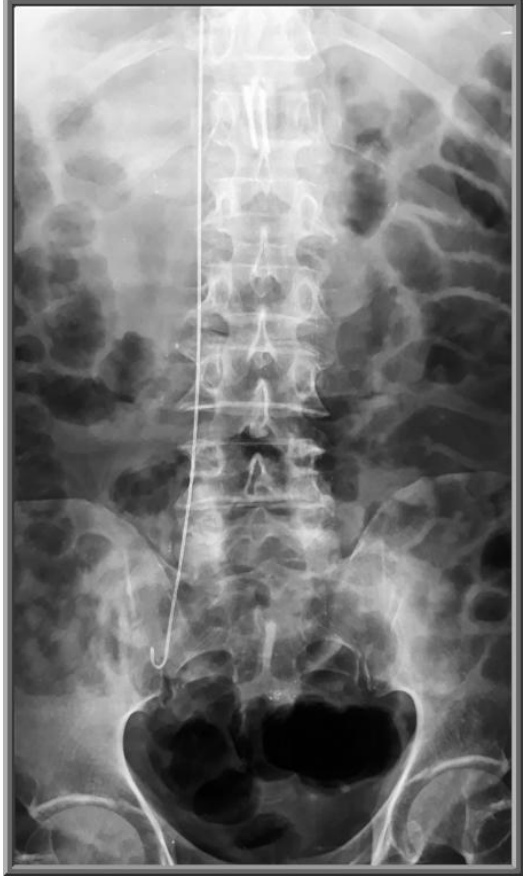
Figure 1: “ J ” guide wire extending from sub hepatic IVC in to right common iliac vein (course through right atrium and supra hepatic IVC not